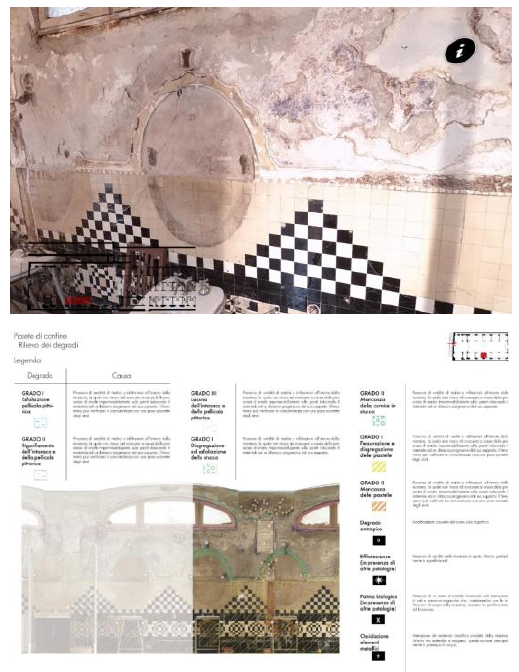
Figure 8. Some images from the work at Diurno di Porta Venezia (the icon with an “i” opens the information report).